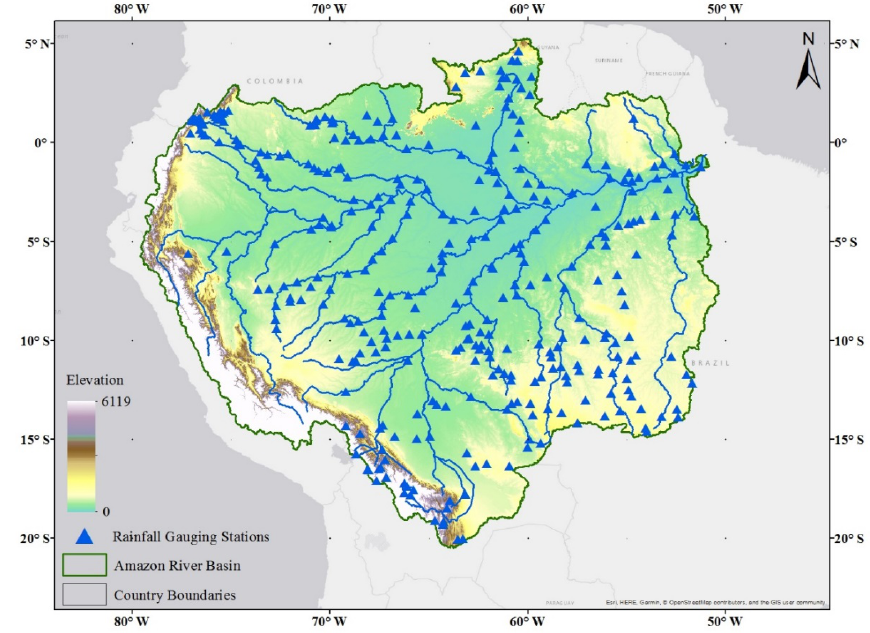
Figure 1. Location of precipitation gauging stations and major streams in the Amazon River Basin.